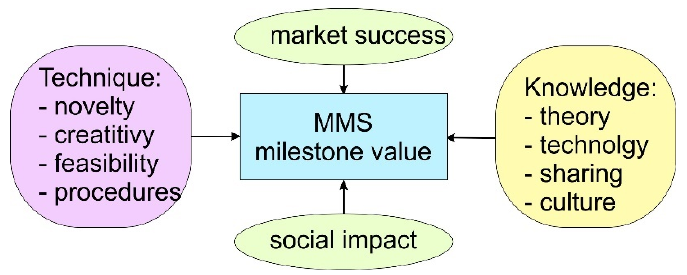
Figure 8. A scheme for milestone values of MMS achievements.